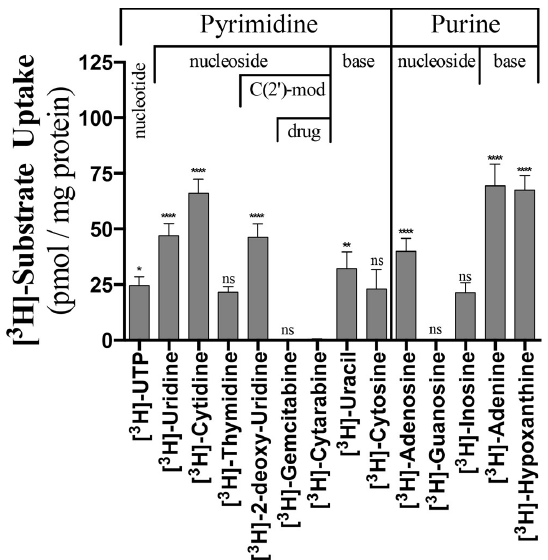
Figure 6. Uptake of radiolabeled substrates into ScENT1 (–OH) PLs. All substrates tested in this study were tested in PLs prepared in the absence of residual alcohols and are divided into pyrimidine and purine classifications further separated into nucleotide, nucleoside, and nucleobase categories with C(2′)-modification noted. Data represents the mean uptake from N = 9 (Native) and N = 3 (L390A and F249I) independent observations for each substrate tested (100 nM final concentrations), and N -values are presented on the graph. PLs were incubated with substrate for 3.5 h prior to being vacuumed filtered onto membranes. Error bars represent the S.E.M. Statistical significance was determined by comparing the mean substrate uptake (pmol substrate/mg ScENT1) for substrates relative to [ 3 H]-cytarabine uptake by PLs using ordinary one-way analysis of variance and Dunnett’s multiple comparison test. Negative control PLs and substrate specific activity are included in the pmol substrate/mg ScENT1 calculation for each sample (see Methods). ns, not significant; * p < 0.05; ** p < 0.01; **** p < 0.0001.